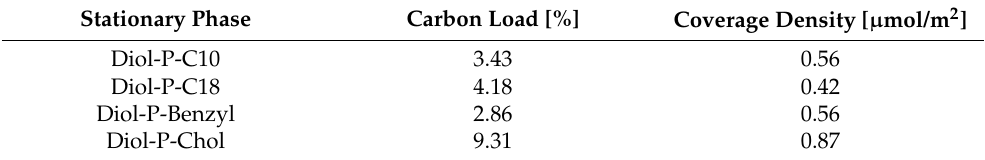
Table 2. Characteristics of stationary phases used in the